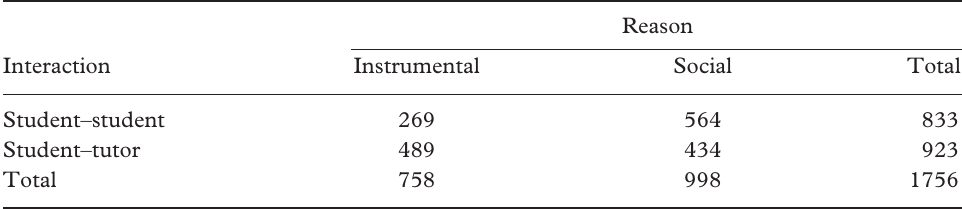
Table 1. Summary of student–student and student–tutor postings for instrumental and social